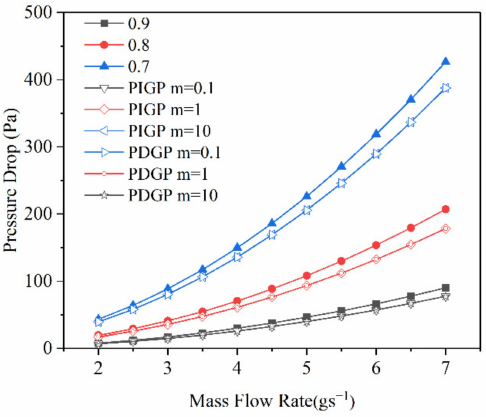
Figure 11. Pressure drop with AFHS of gradient porosity designs in the Z -axis direction.